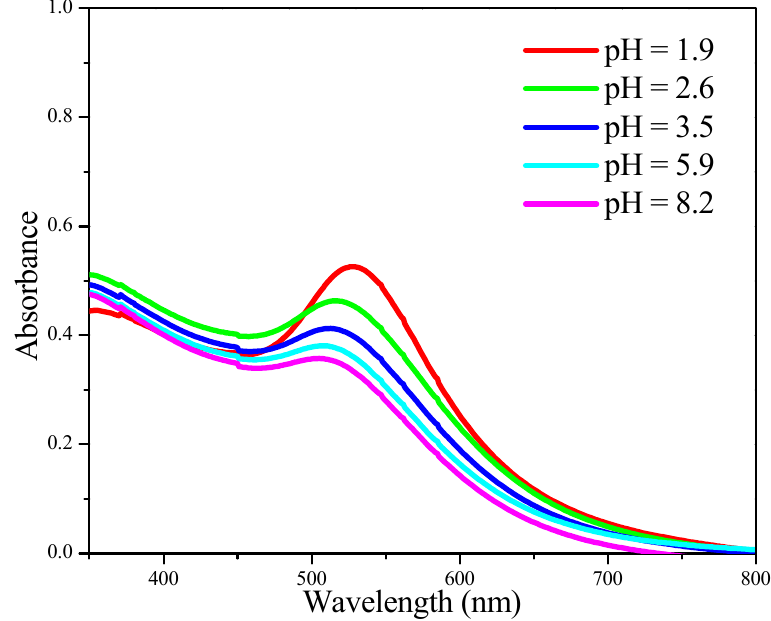
Figure 3. UV-Vis spectra recorded after adjusting the pH value of a 5.7 nm Au colloid solution by different amounts of aqueous